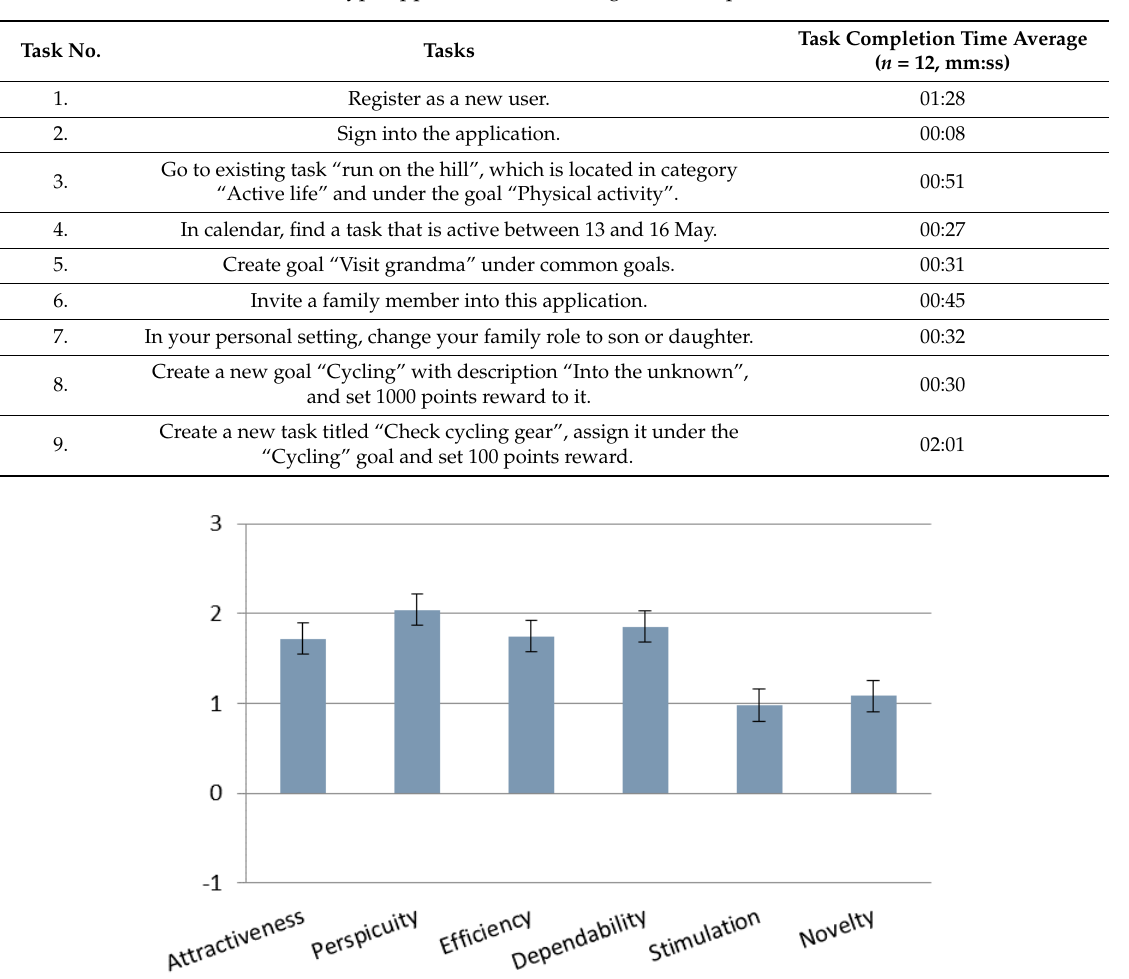
Table A1. Prototype application user testing: Task completion time results.